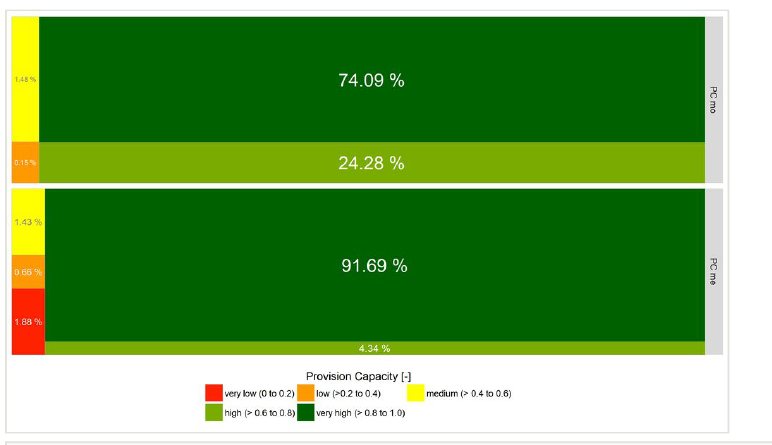
Figure 10. Areal proportions of the soil erosion indicators describing the provision capacity (PC based on modelled actual soil loss data; PC : based on mapped actual soil loss data). The treemaps visualise the proportions of the provision capacity classes for the whole investigation